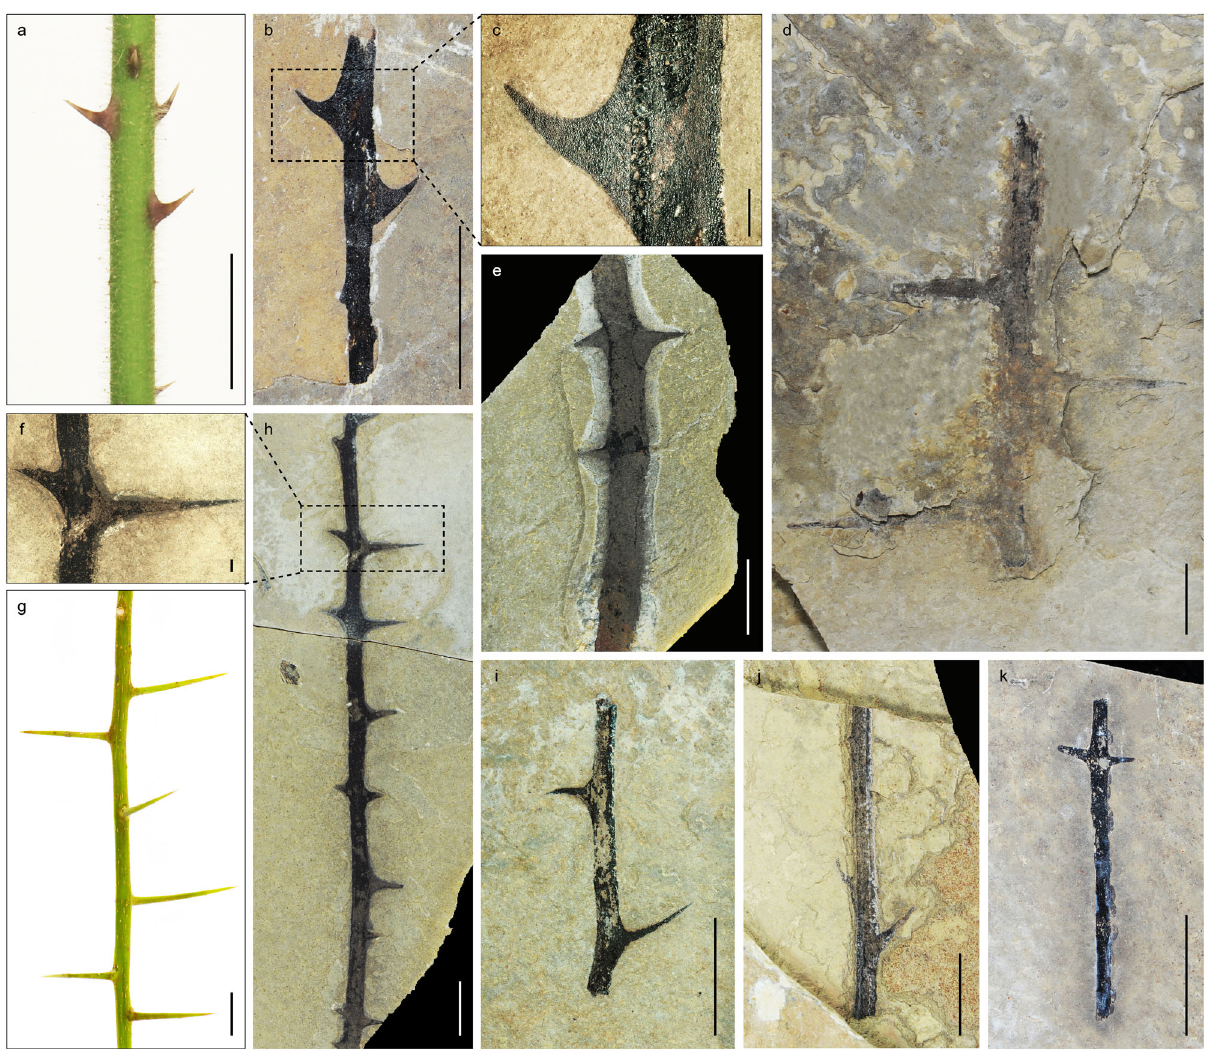
Fig. 2 Morphotypes of spiny fossils from the upper Eocene Dayu and Xiede sections, central Tibetan Plateau. a Prickles of living species Rubus alceifolius . b , d , e, h – k , Seven morphotypes of spiny fossils. c Enlargement of b . f Enlargement of h . g Thorns of living species Xylosma racemosum . (For c , f , scale bars = 1 mm; for others, scale bars = 10